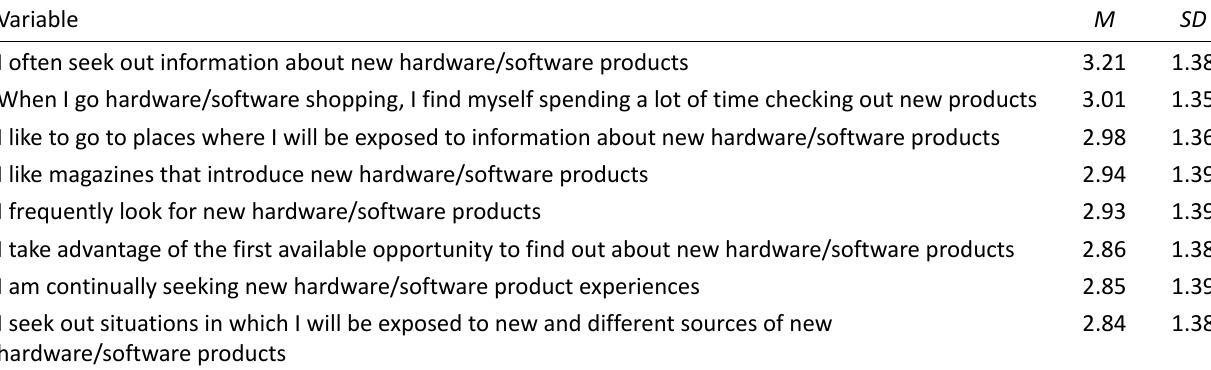
Table 1. Means of early technology adoption by scale item. Variable